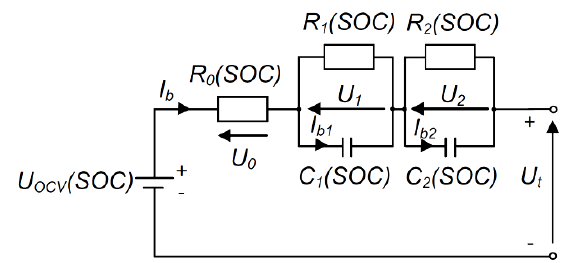
Figure 3. Substitute diagram of the double polarization (DP) model.